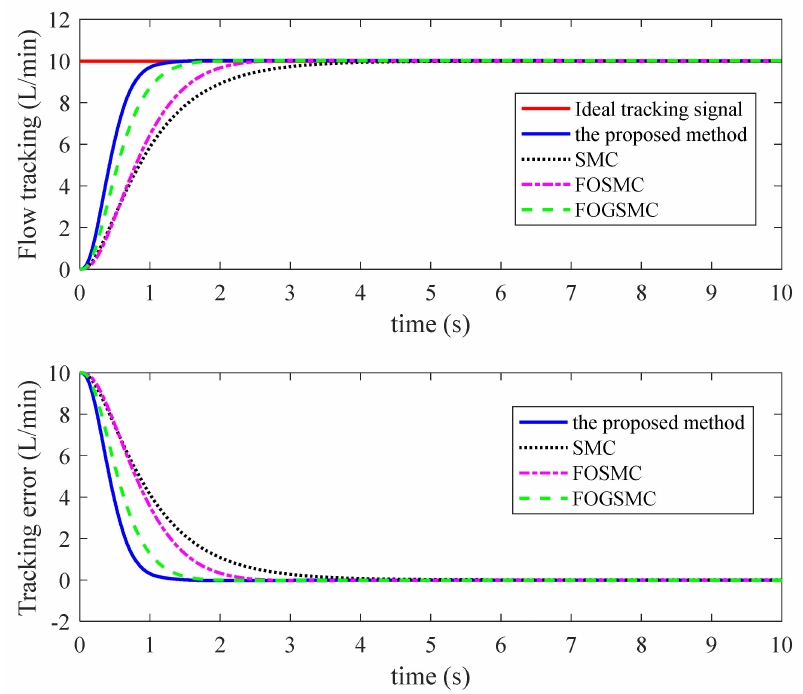
Figure 5. Time response of glue flow tracking and tracking error.